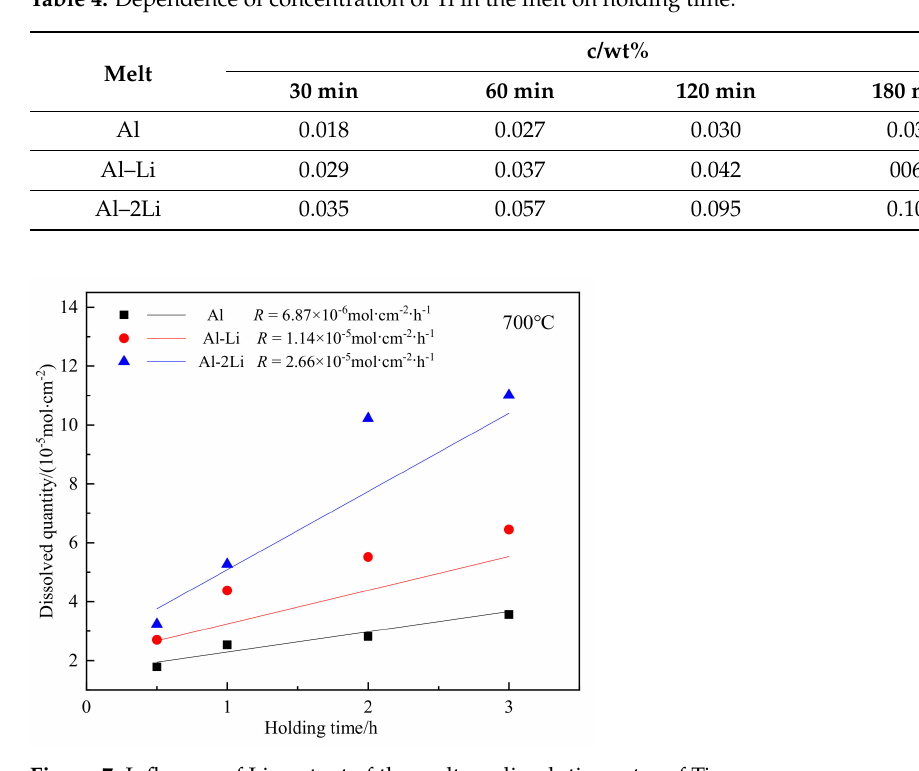
Figure 7. Influence of Li content of the melt on dissolution rates of Ti.